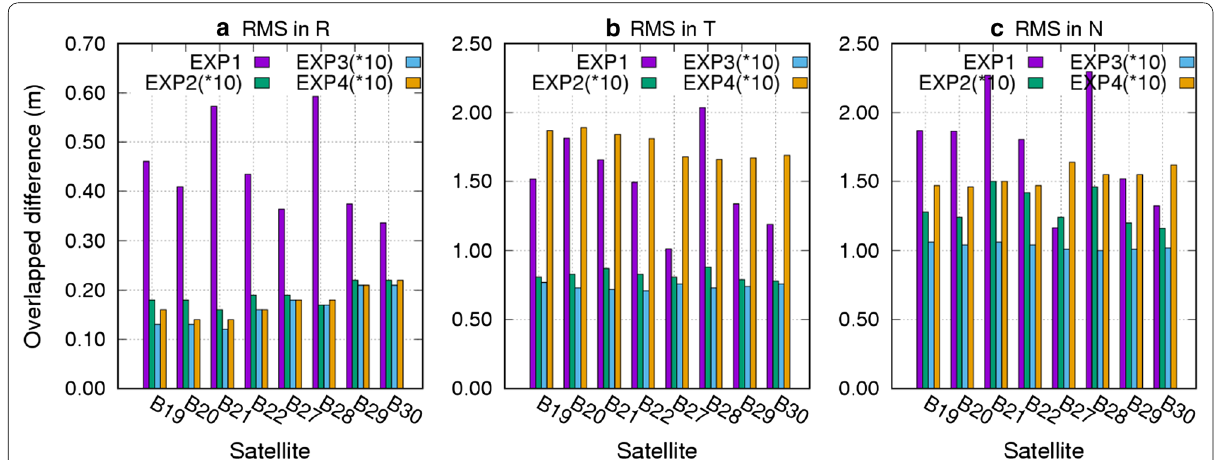
Fig. 2 RMS of overlap orbit differences in R, T, and N for each satellite. The values of EXP2, EXP3, and EXP4 have a tenfold magnification to illustrate the differences between